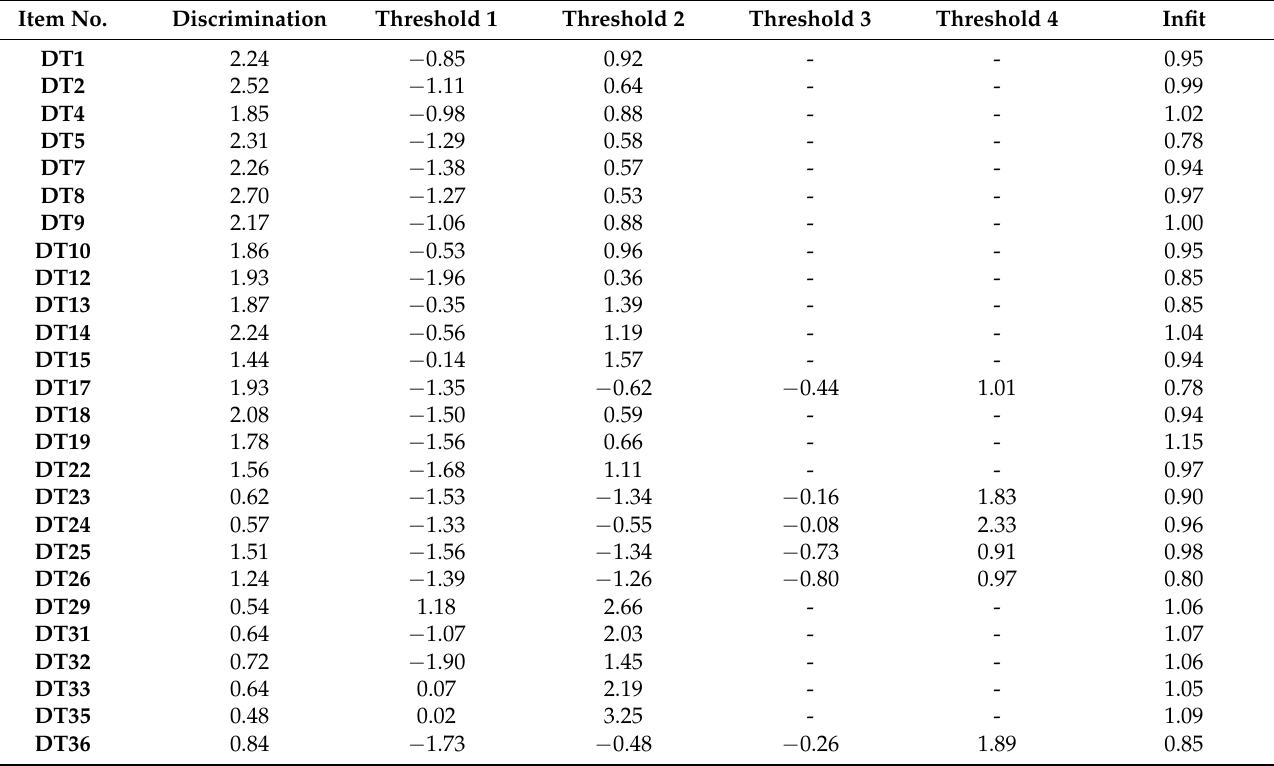
Table A1. Parameter estimates (discrimination and thresholds) and fit statistics for the 26 items in the final PREMIUM-DT item bank.